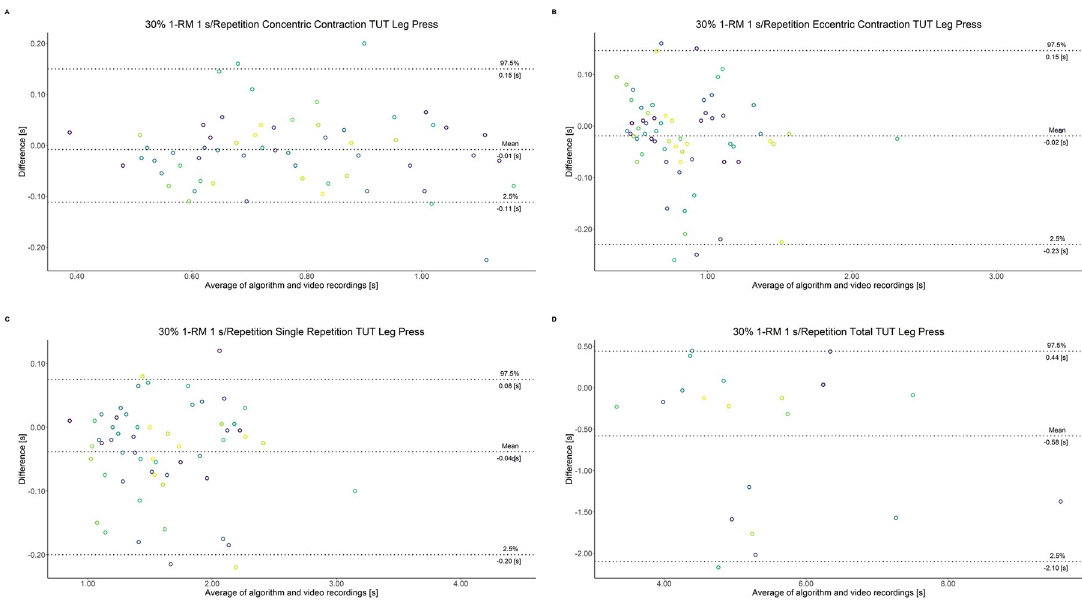
Fig 7. Bland-Altman plots of agreement between algorithmically accelerometer derived and video recordings derived contraction- specific phases of the leg press machine at 30% 1-RM with a velocity of 1 s per repetition. A: Concentric contraction phase. B: Eccentric contraction phase. C: Single repetition. D: Total time-under-tension.